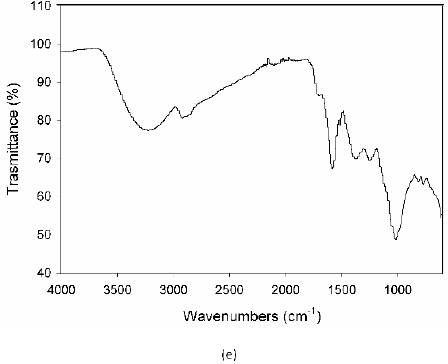
Figure 4. IR spectra of the MCE-20% AG ( w / w ) after 24 h of degradation at 70 °C-75% RH ( a ), after 4 h ( b ) and 3 days of degradation at 70 °C-30% RH ( c ), and after 3 ( d ) and 7 days of degradation at 25 °C-75% RH ( e ).